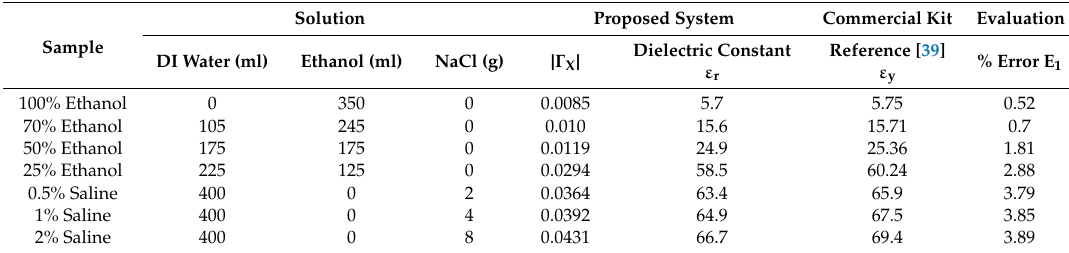
Table 2. Measured dielectric constants using the proposed and commercial